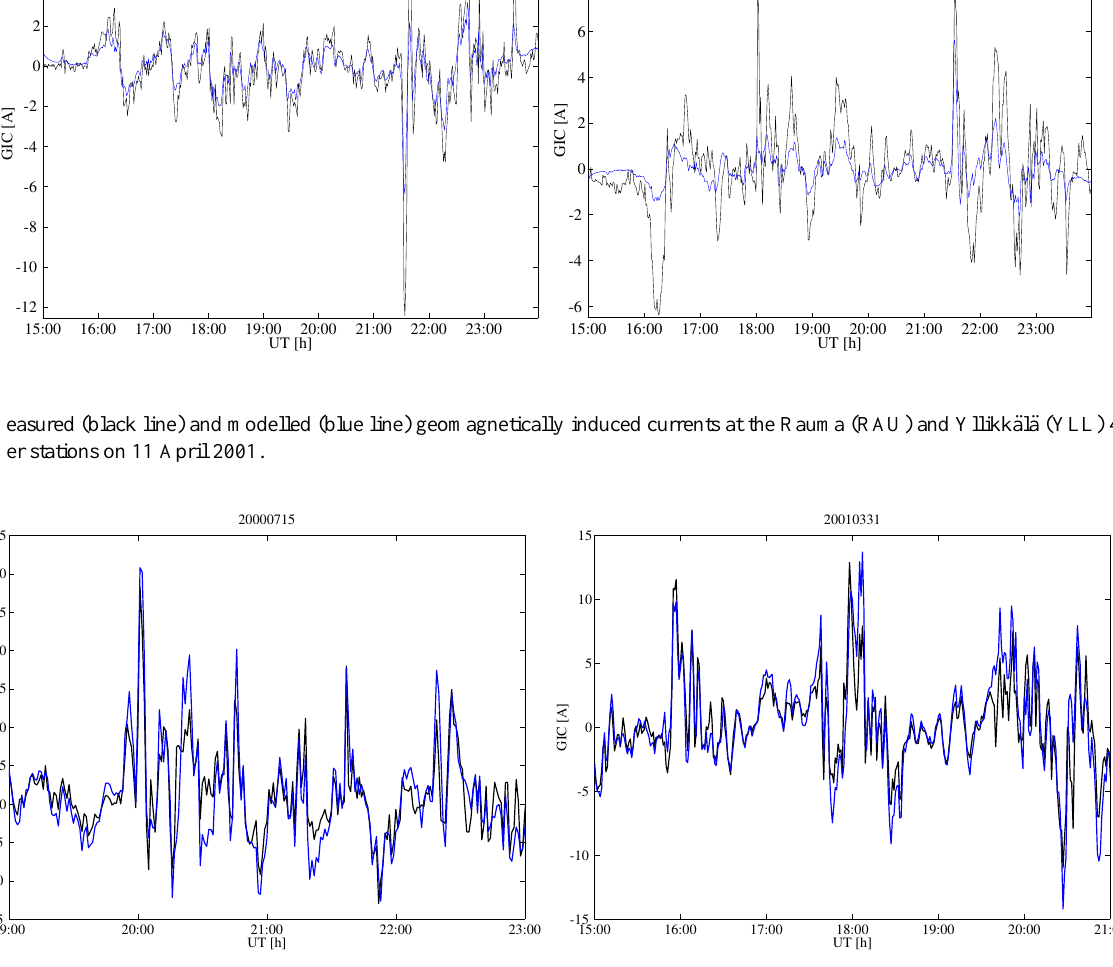
Fig. 9. Measured (black line) and modelled (blue line) geomagnetically induced currents along the Finnish natural gas pipeline at M¨ants¨al¨a on 15 July 2000 and on 31 March 2001. The geoelectric field is calculated by the complex image method.